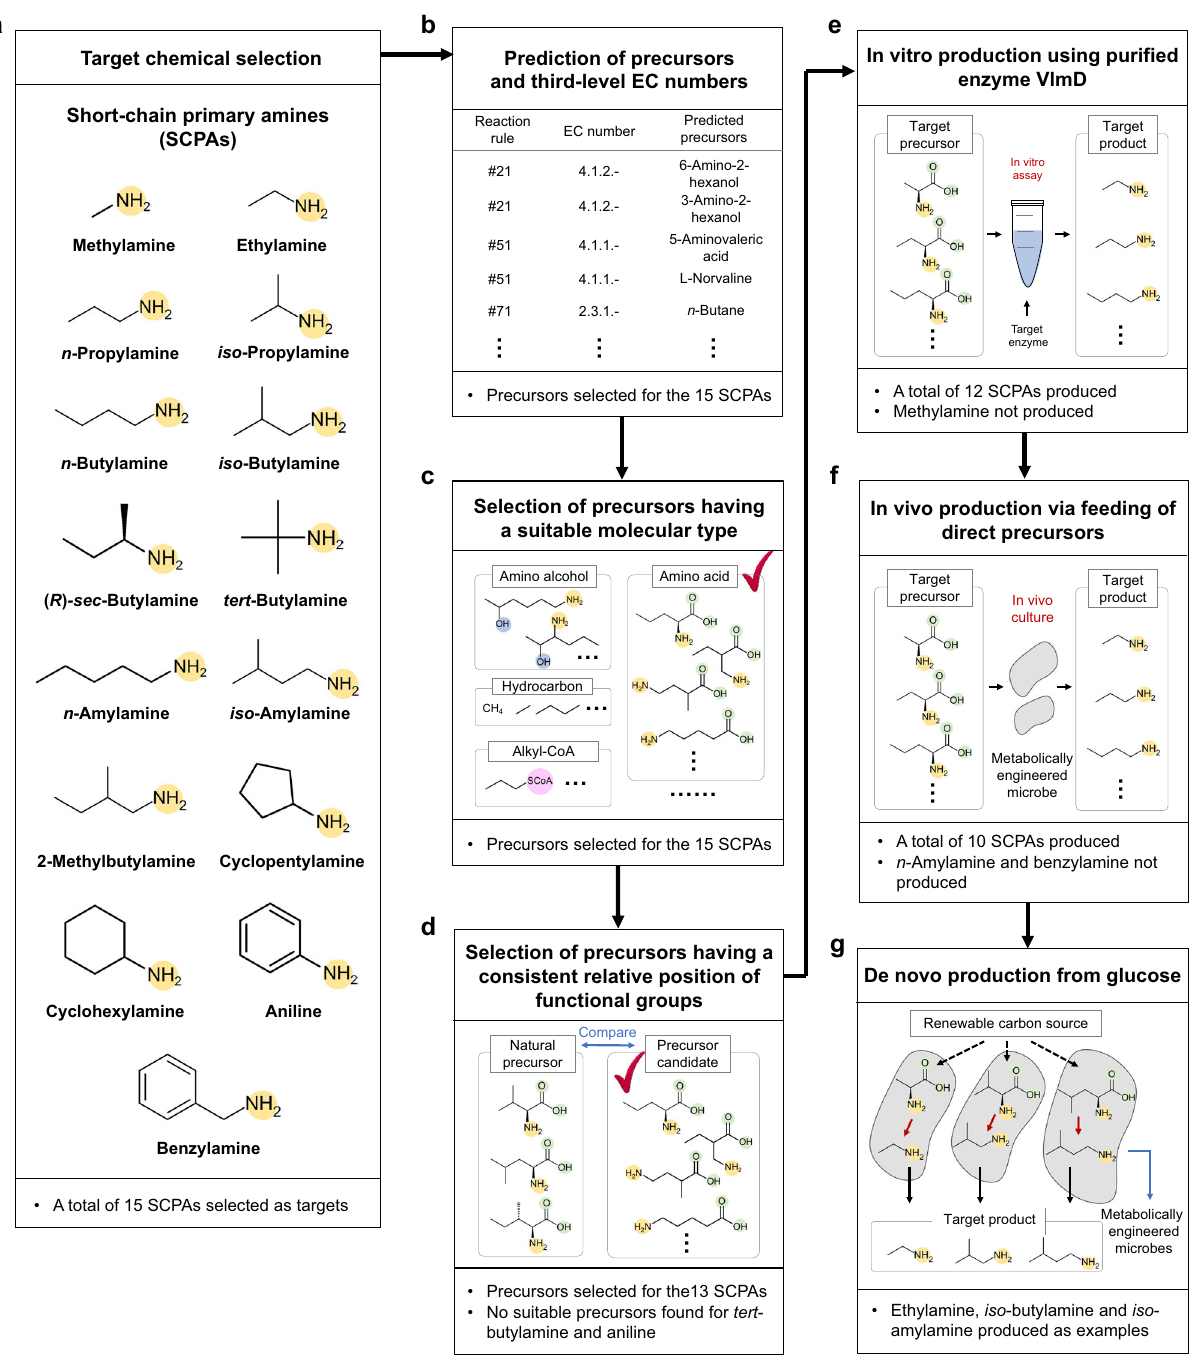
Fig. 1 Overall work fl ow for the microbial production of 15 short-chain primary amines (SCPAs). The work fl ow implemented in this study largely consists of the following steps: ( a ) target chemical selection; ( b ) prediction of precursors and relevant third-level EC numbers for the generation of these precursors; ( c ) selection of precursors having a suitable molecular type; ( d ) selection of precursors having a consistent relative position of functional groups; ( e ) in vitro production using puri fi ed enzyme VlmD; ( f ) in vivo production via feeding of direct precursors; and ( g ) de novo production from glucose. Amine, carboxylic, hydroxy and CoA groups are presented with yellow, green, blue, and pink circles, respectively. In ( c ) and ( d ), these two steps are collectively referred to as the precursor selection step where precursors that meet the selection criteria are presented with a check